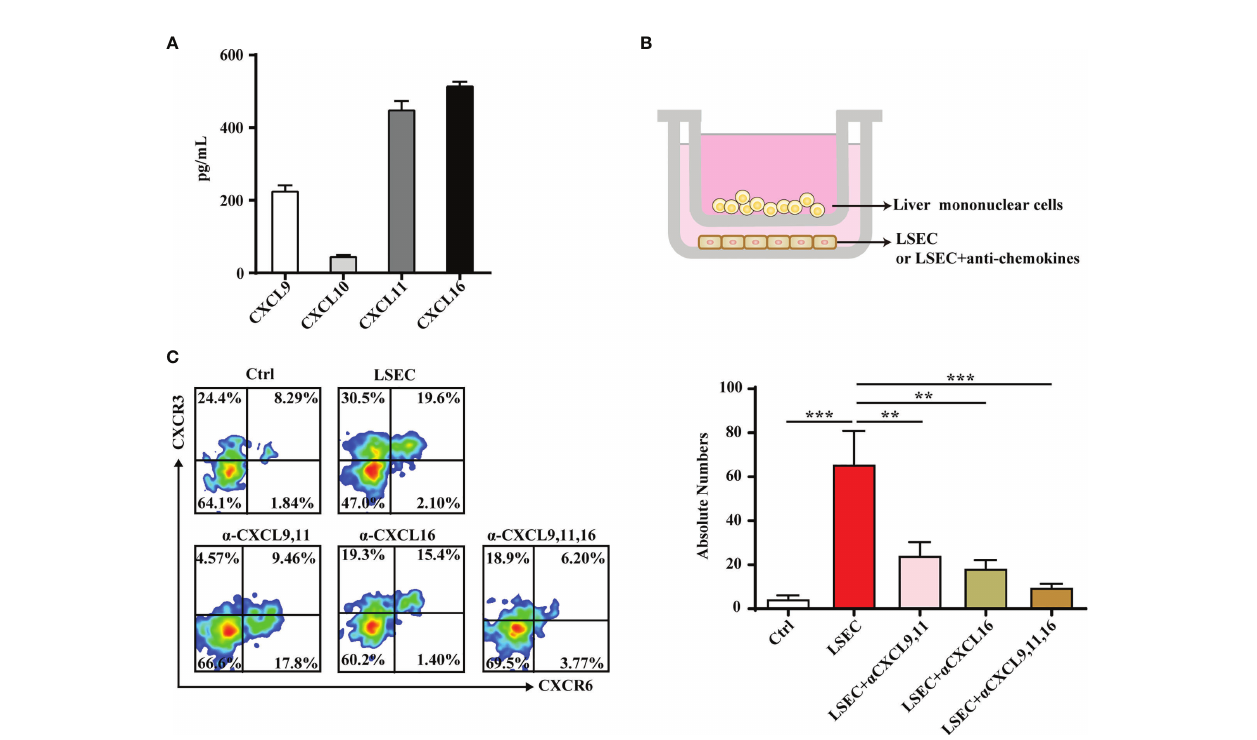
FIGURE 5 | LSECs promote the recruitment of CXCR3 + CXCR6 + gd T cells to the liver. (A) Freshly isolated LSECs (1 × 10 5 per well) were seeded into 24-well plates and incubated at 37°C. The culture supernatant of each well was collected at 24 h and CXCL9, CXCL10, CXCL11, and CXCL16 levels in the culture supernatant were detected by ELISA. (B) Transwell was performed to test the chemotactic effect of LSECs to CXCR3 + CXCR6 + gd T cells. The inserts were seeded with 5 × 10 5 liver mononuclear cells in 100 µl serum-free RPMI-1640 media. The lower chamber contained 500 µl DMEM medium with untreated LSECs or LSECs incubated with neutralizing antibodies speci fi c for indicated chemokines at 37°C for 2 h. (C) FACS analysis (left) and absolute numbers (right) of CXCR3 + CXCR6 + gd T cells in the lower chamber migrated from the upper insert after a 2-h incubation. Data are shown as mean ± SEM. (** p < 0.01; *** p < 0.001. One-way ANOVA with post-hoc